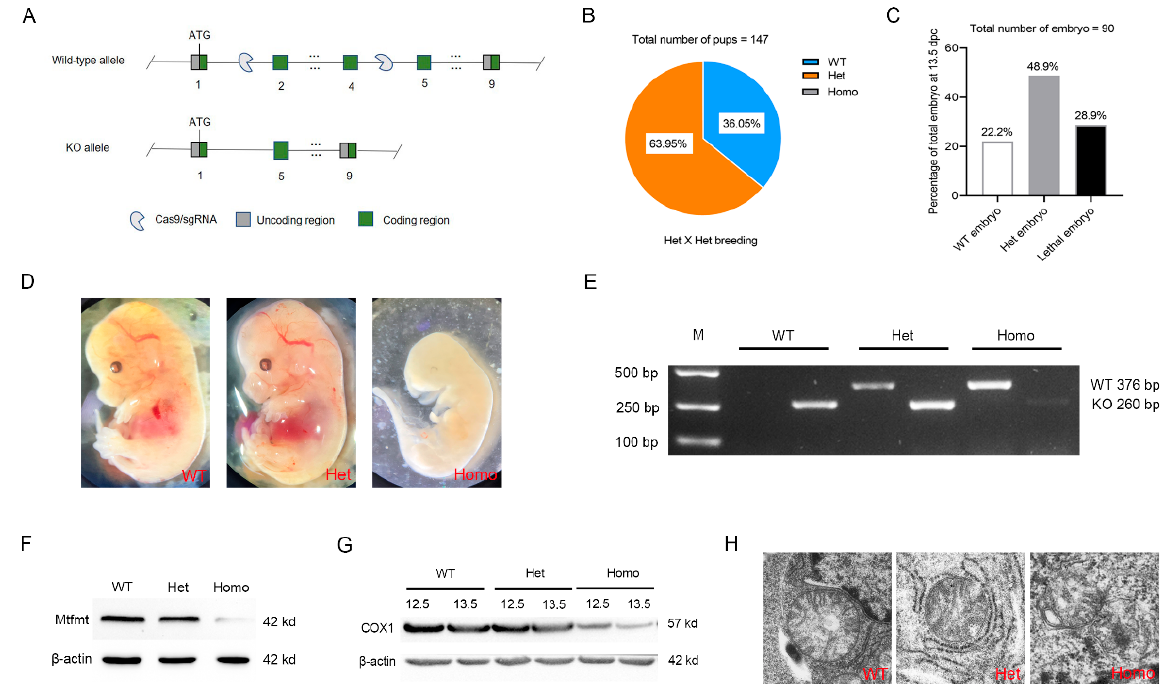
Figure 2. Mtfmt deletion caused embryonic lethality in mice. ( A ) Disruption of Mtfmt in ES cells by CRISPR-Cas9 technology. ( B ) Percentages of different genotypes of the pups from Het × Het breeding. WT: wild type, Het: heterozygous, Homo: homozygous. The total number of pups analyzed was 147. ( C ) The percentages of embryos with different genotypes at 13.5 dpc. The total number of embryos analyzed was 90. ( D ) Representative images of Homo, Het, and WT embryos. ( E ) Representative genotyping results generated by PCR. Genomic DNA was isolated from mouse embryos. KO mutation can be amplified as a band of 260 bp; WT can be amplified as a band of 376 bp. ( F ) Representative Western blots of Mtfmt and β -actin expression in the embryos. ( G ) Representative Western blots of COX1 and β -actin expression in the embryos at 12.5 dpc and 13.5 dpc. ( H ) Representative images of mitochondria in Homo, Het, and WT embryos (scale bar, 500